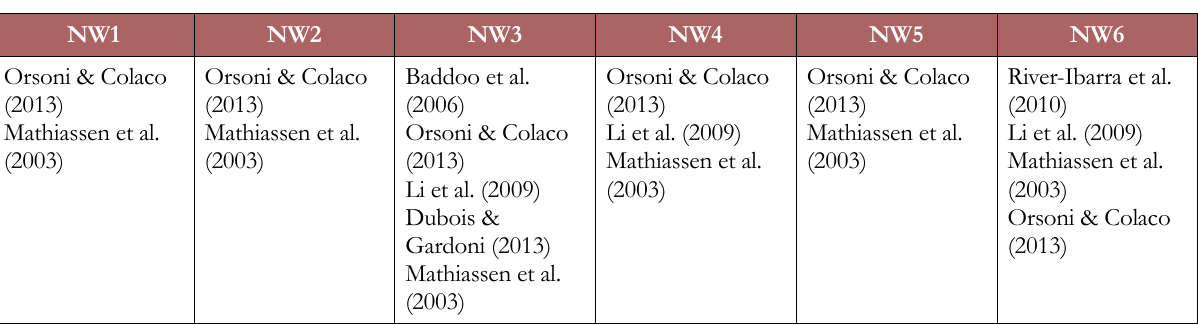
Table 8. FINCODA Networking supporting